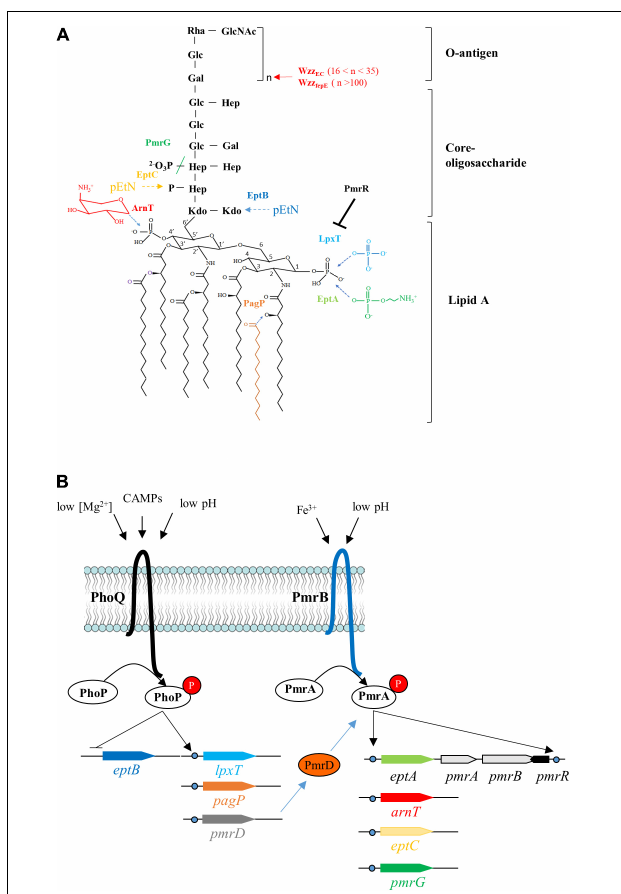
FIGURE 1 | Lipopolysaccharide modifications and their regulation in E. coli . (A) The structure of the unmodified lipopolysaccharide (LPS) from E. coli is shown in black. The chemical modifications and/or the corresponding enzymes catalyzing them are color-coded. The added chemical groups and the enzymes are similarly colored and the dotted arrows indicate the sites of modification. The colored slash indicates the hydrolysis of a chemical bond by PmrG. Wzz EC and Wzz fepE control the number of O-antigen subunits (n) to be added to the lipid A–core, with the corresponding value of n indicated between brackets. PmrR is a membrane peptide which inhibits the phosphotransferase activity of LpxT. (B) The two-component systems (TCS) PhoPQ and PmrAB regulate the expression of genes encoding the major LPS modifying enzymes, the regulatory membrane peptide PmrR, the TCS connector PmrD or PmrAB proteins. The stimuli that are recognized by the sensor proteins from these TCS are indicated. Rha, rhamnose; GlcNAc, N -acetylglucosamine; Glc, glucose; Hep, heptose; Gal, galactose; Kdo, 3-deoxy-D-manno-oct-2-ulosonic acid; pEtN,